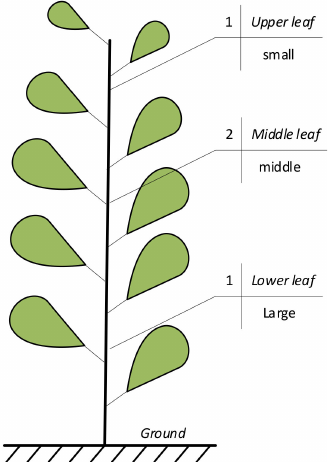
Figure 1. Pepper plant leaf position.